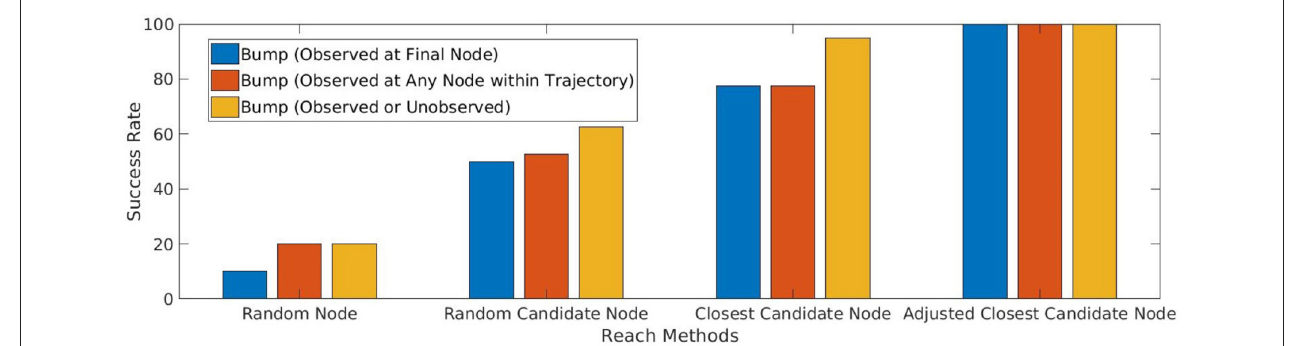
FIGURE 7 | Reliability of the agent’s action to reach and bump a single target object by following a trajectory to a selected target node. The four groups represent (1) randomly selected target node; (2) random selection from among candidate nodes with non-empty image intersections; (3) select closest among candidate nodes; (4) adjust node with local Jacobian to best match target object. Within each group, the bars represent different criteria for success: (l) observed bump at final node, which measures the agent’s ability to cause bumps intentionally and efficiently; (m) observed bump anywhere in the trajectory, which identifies bumps that can be learned from; (r) any bump, observed or unobserved, which measures ground truth of bump